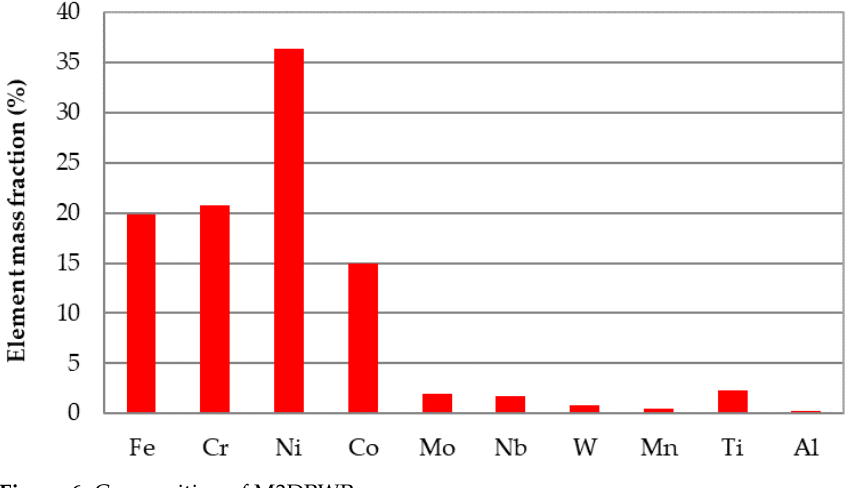
Figure 6. Composition of M3DPWP.